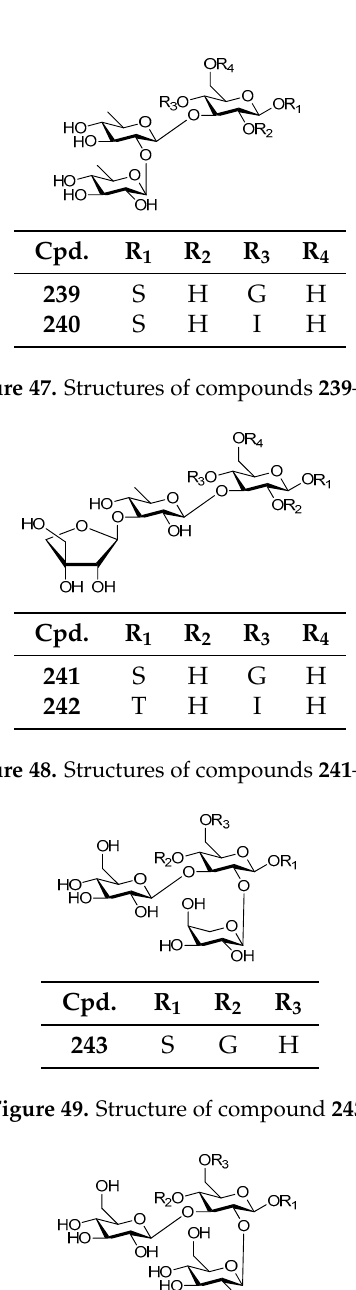
Figure 50. Structure of compound 244 . Cpd.